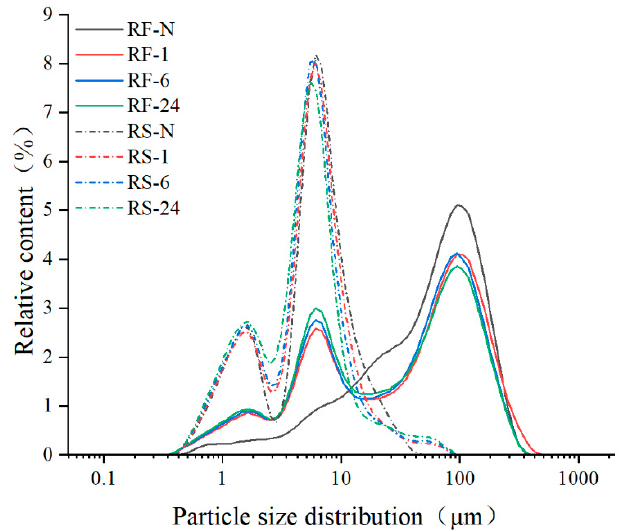
Figure 2. The particle size distribution of native and partially hydrolyzed RF and RS. RF represents rice flour and RS represents rice starch; numbers refer to the hydrolysis time (h); RF-N is native rice flour and RS-N is native starch isolated from rice flour.